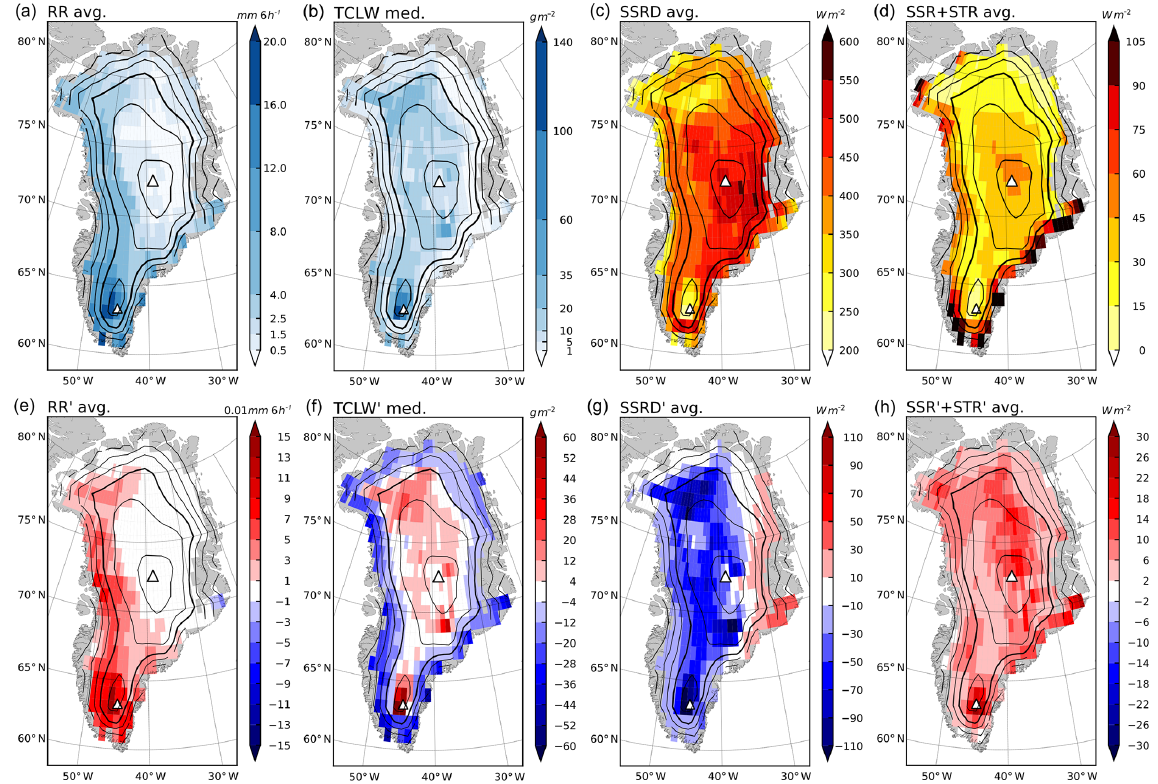
Figure 13. As Fig. 7 but for melt trajectories during all large-scale melt events.